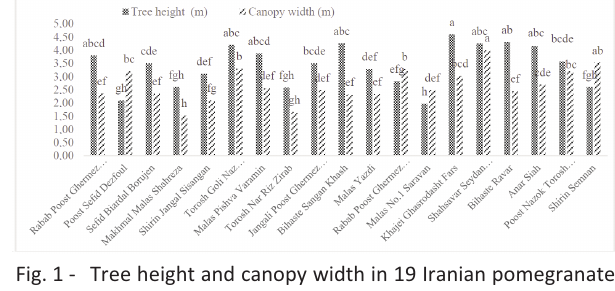
Fig. 1 ­ Tree height and canopy width in 19 Iranian pomegranate cultivars. Similar letters indicate non­significant differen­ ces among cultivars (P≤0.05).